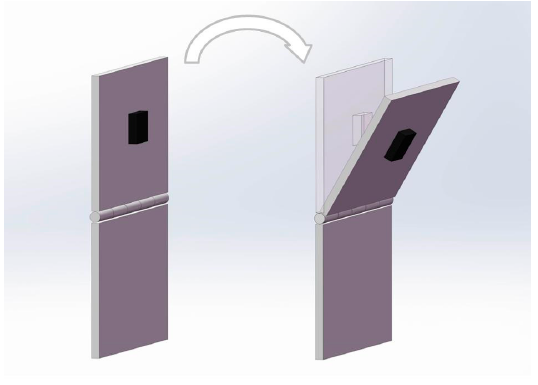
Figure 8. The process of introducing the displacement by hinge.